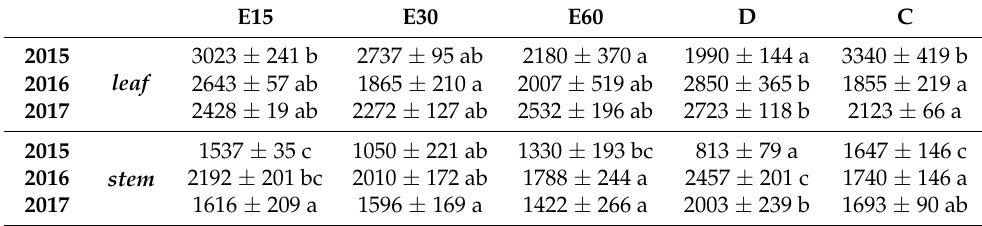
Table 6. Phosphorus content measured in the plant parts of SRC willow clones irrigated with effluent water from an intensive catfish farm. Average phosphorus content data are presented from five treatments. Results are means ± SD, n = 6. Different letters introduce significant differences among irrigation water qualities for the three vegetation seasons, confirming to the Tukey’s test at p ≤ 0.05. E15 E30 E60